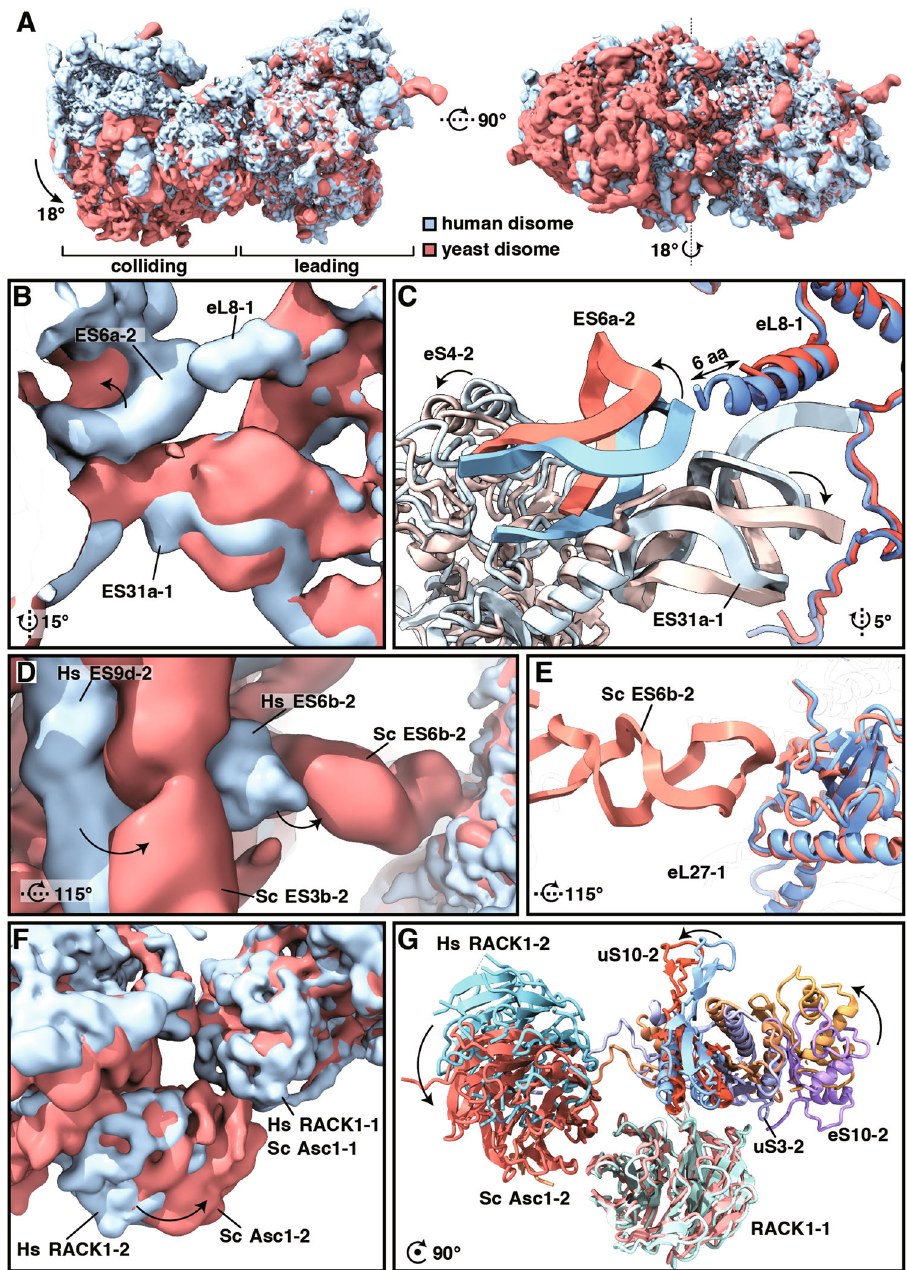
Fig. 3 | Structural comparison of the human and the yeast disome. Cryo-EM densities and models are colored in shades of blue for the human disome and red forthe yeastdisome (EMD-4427[https://www.ebi.ac.uk/emdb/EMD-14181],PDBID: 6I7O [https://doi.org/10.2210/pdb7QVP/pdb]) in all panels. Focused views with indicated rotations refer to panel A left. A Overlay of the cryo-EM densities of the human and the yeast disomes shows an apparent 18° rotation of the colliding